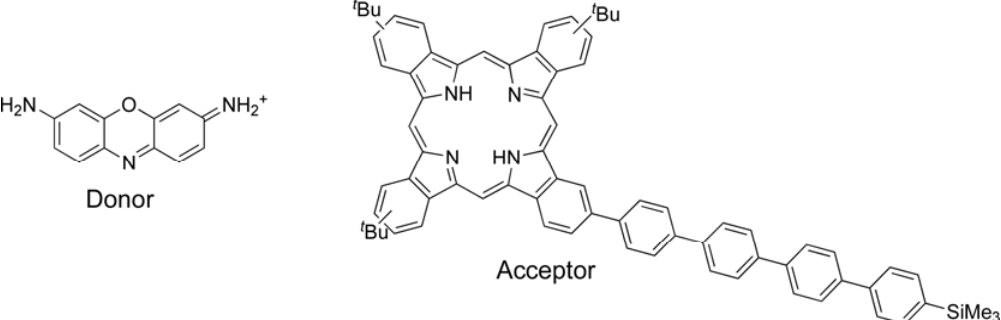
Figure 7. Donor and acceptor dyes trapped in zeolite